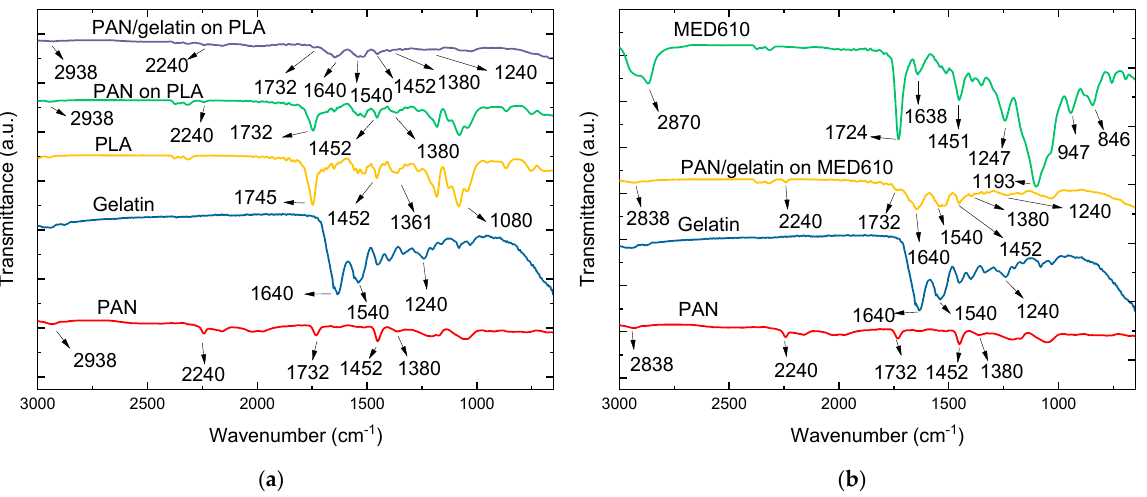
Figure 8. FTIR results: ( a ) PAN/gelatin nanofiber mats on PLA sample, PAN nanofiber mats on PLA sample, PLA sample without coating with nanofiber mat, pure gelatin, and PAN nanofiber mat; ( b ) MED610 sample without coating with nanofiber mat, PAN/gelatin nanofiber mats on MED610, pure gelatin, PAN nanofiber mat. Table 3. Overview of the typical FTIR spectra of MED610, PLA and nanofiber mats. Polymers